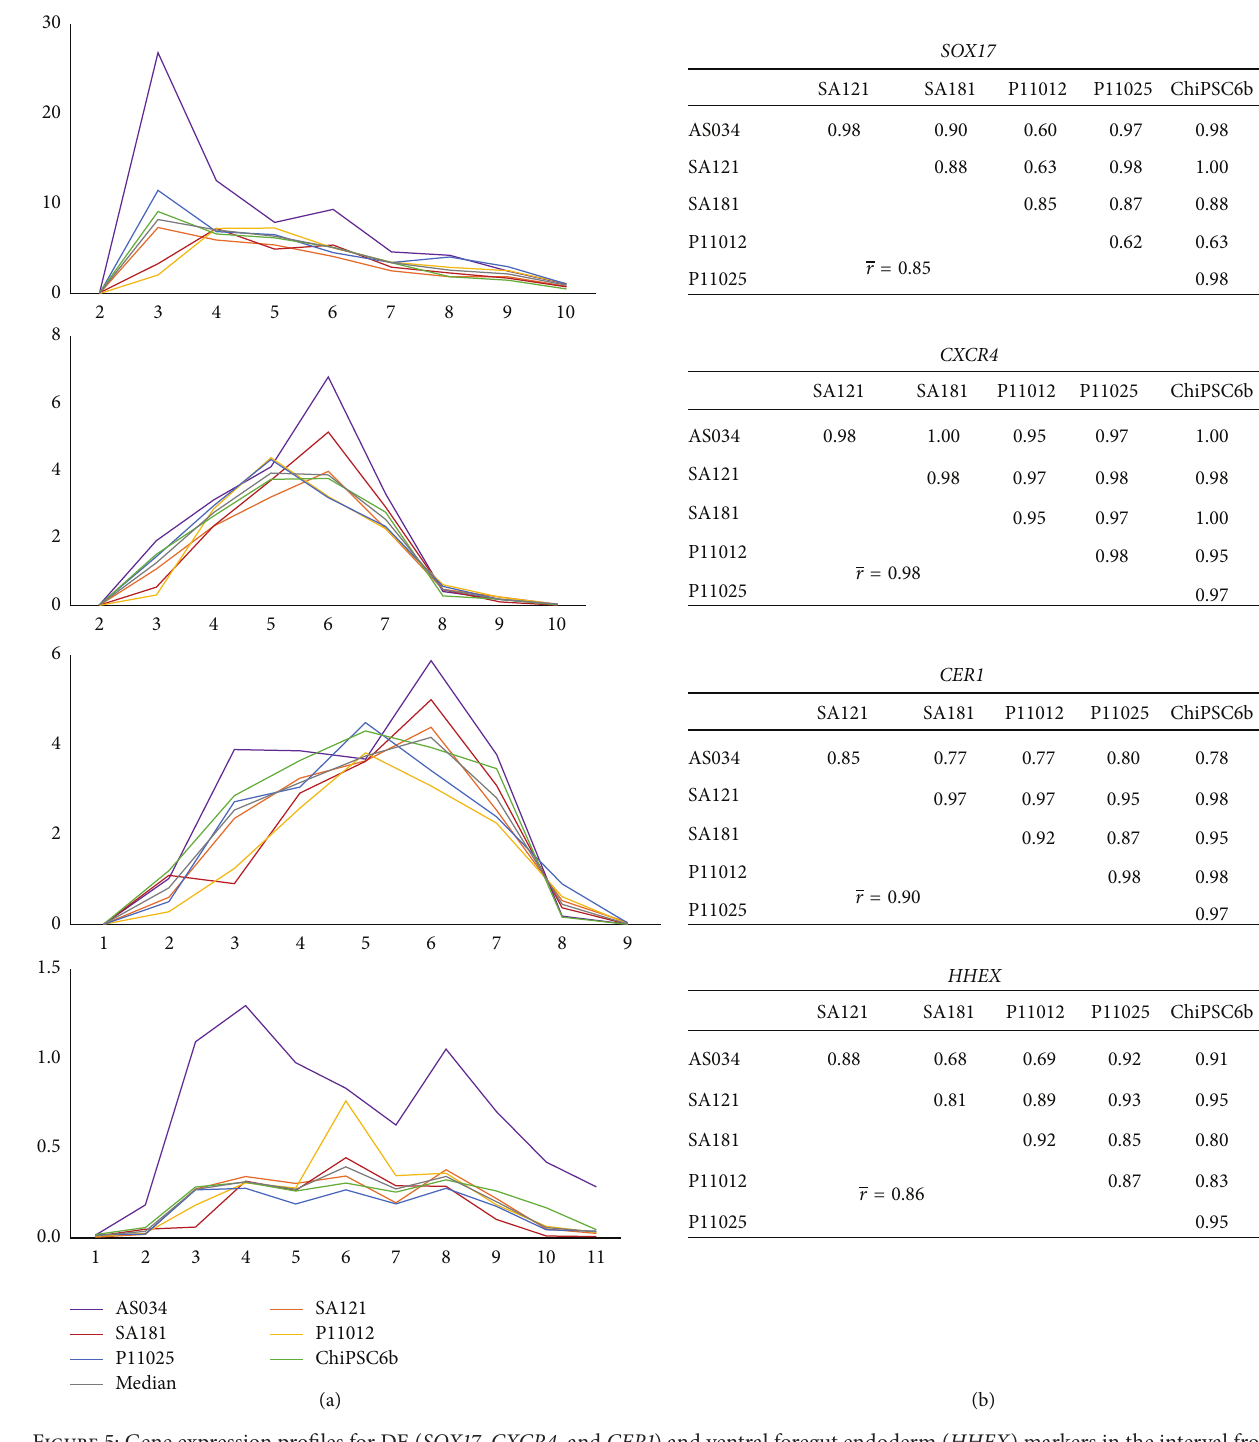
Figure 5: Gene expression profiles for DE ( SOX17 , CXCR4 , and CER1 ) and ventral foregut endoderm ( HHEX ) markers in the interval from day 1 to day 11. (a) The 𝑥 -axis indicates the days during differentiation and the 𝑦 -axis indicates RQ, where the calibrator’s RQ = 1. The colored lines show the results from each individual hPSC line and the grey line indicates the calculated median value of the RNA level. Correlation tables are shown in (b). The time points before the onset of expression and after the RNA levels have decreased below the detection limit are not included in the analysis (e.g., day 1 and day 11 were excluded for SOX17 ). In general, the correlation between cell lines for all these markers is very strong. DE cells seem to emerge at day 3 and disappear at day